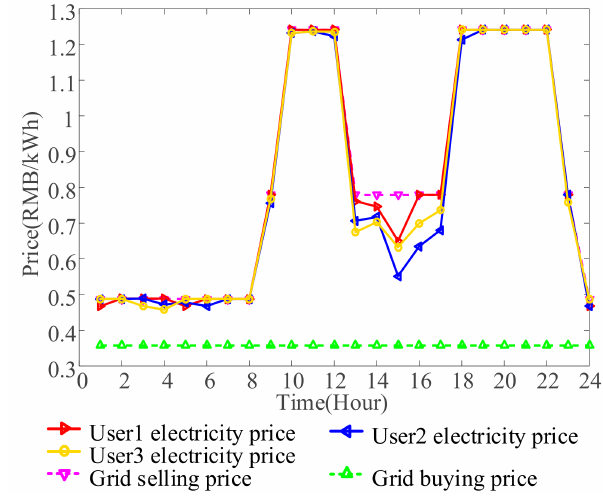
Figure 4. Electricity trading prices after bargaining.